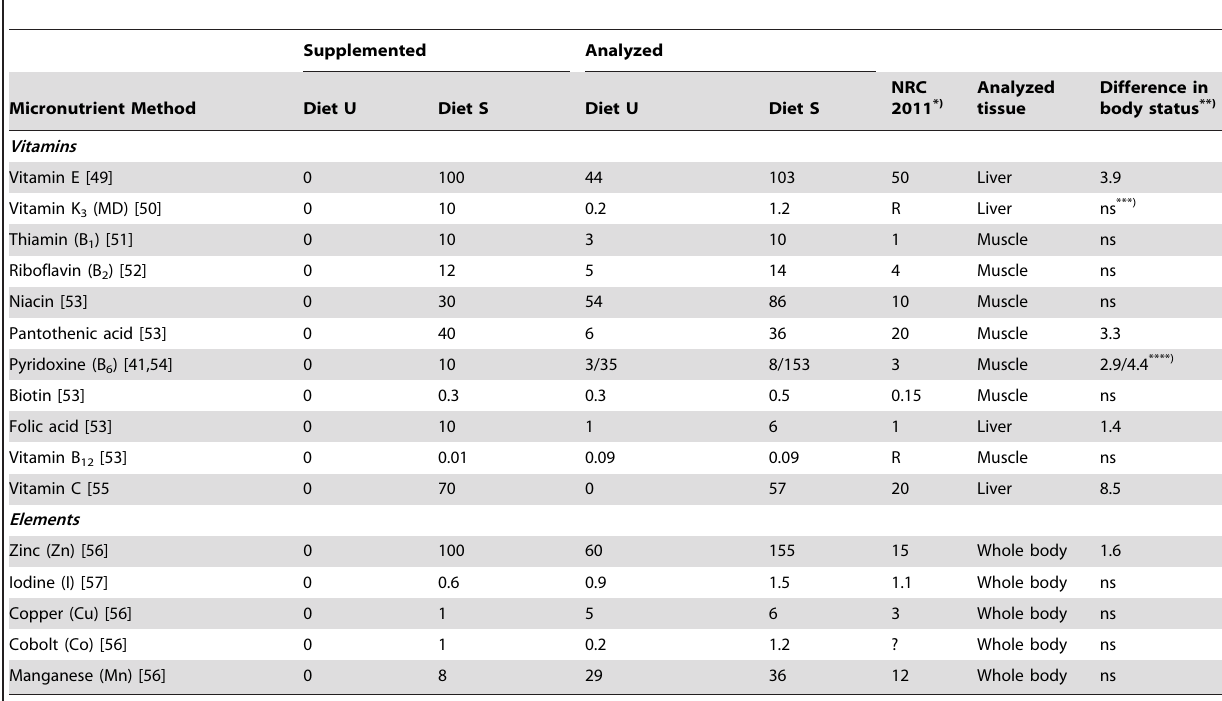
Table 2. Target supplementations of vitamins and minerals (mg kg 2 1 ) from the premix in the two experimental diets (unsupplemented Diet U and supplemented Diet S), respective analyzed feed values, present nutrient requirements from the NRC (2011), and significant changes in respective tissue status between the dietary